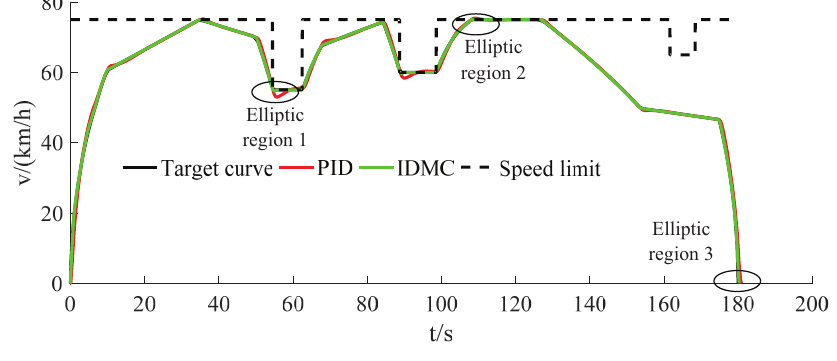
Figure 16. The speed time tracking